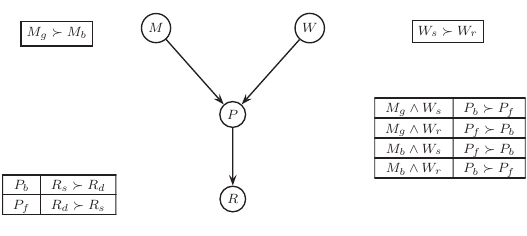
Figure 3. An example of a CP-net named “My Weekend 1 ".